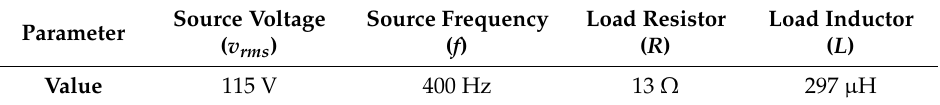
Figure 8. Generalized ( a ) and Saber schematic circuit ( b ) for the three-phase RL network. The parameters of the three-phase RL network are given in Table 2. Table 2. Simulation parameters for three-phase RL